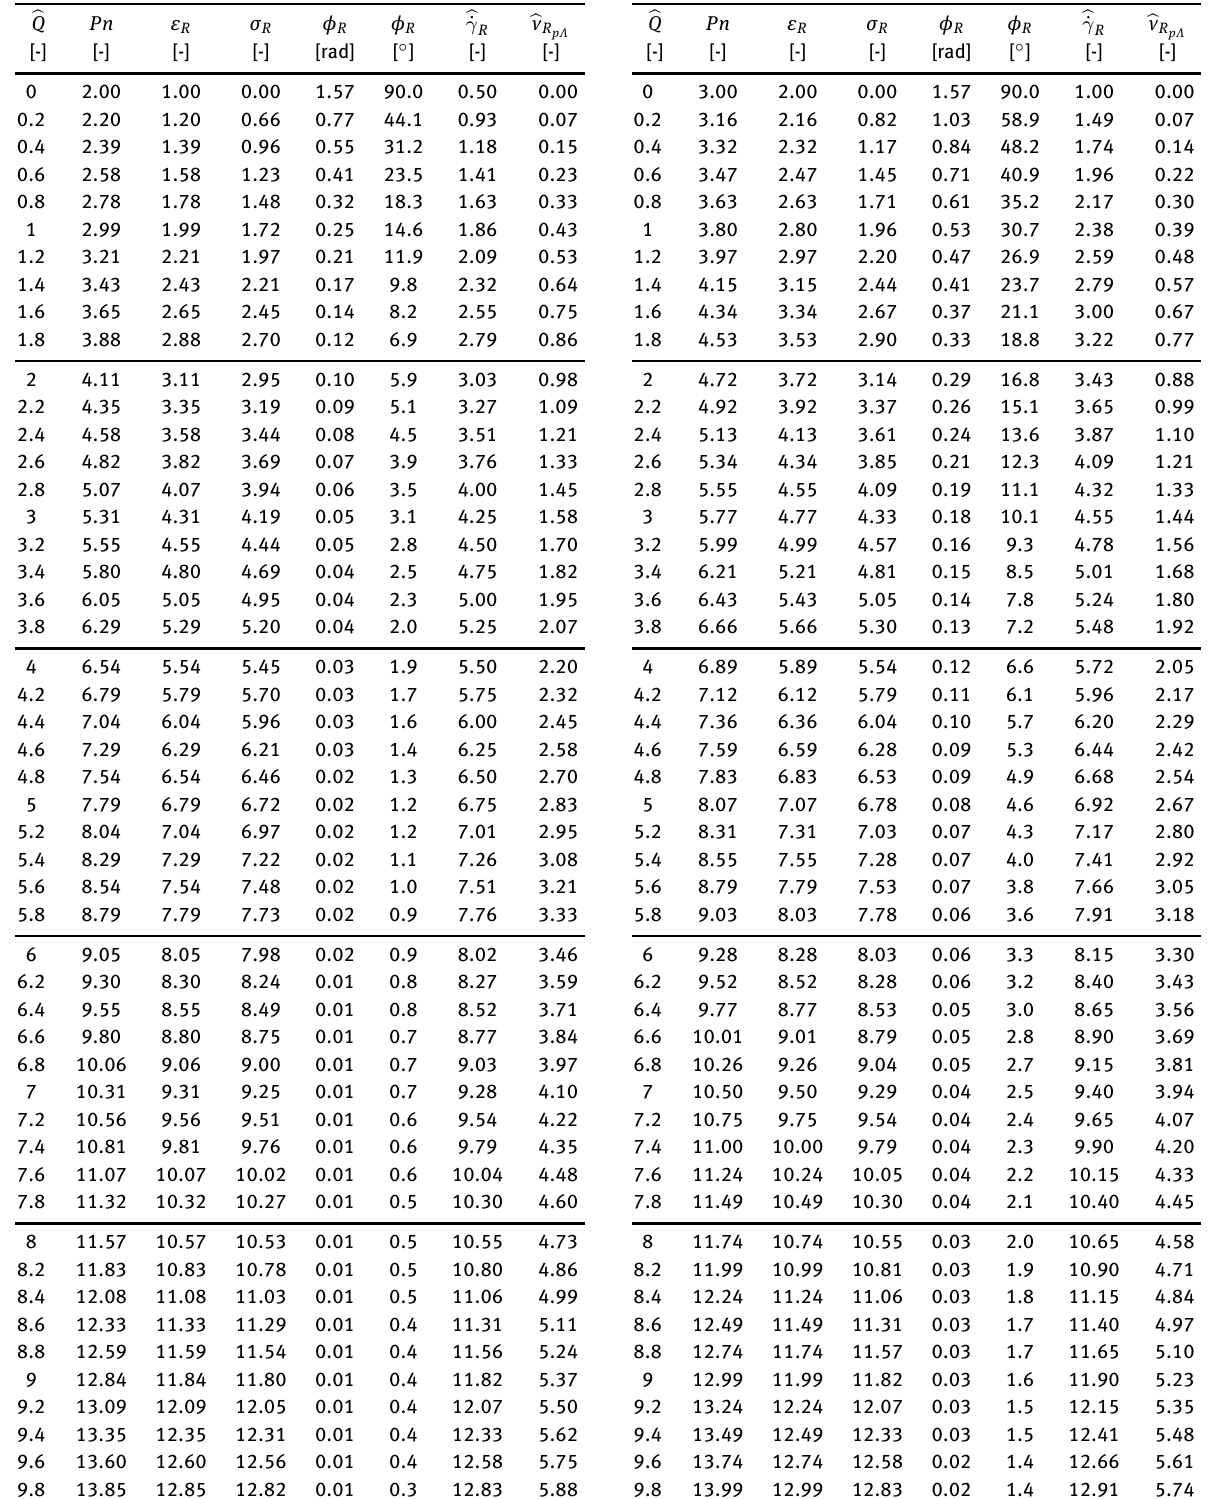
Table E4: Brief summary of numerical values of the discharge rela- Table E5: Brief summary of numerical values of the discharge rela- tions shown in Figure 7 for a thixotropy factor Λ = 2.0 . tions shown in Figure 7 for a thixotropy factor Λ = 3.0 Λ = 2.0